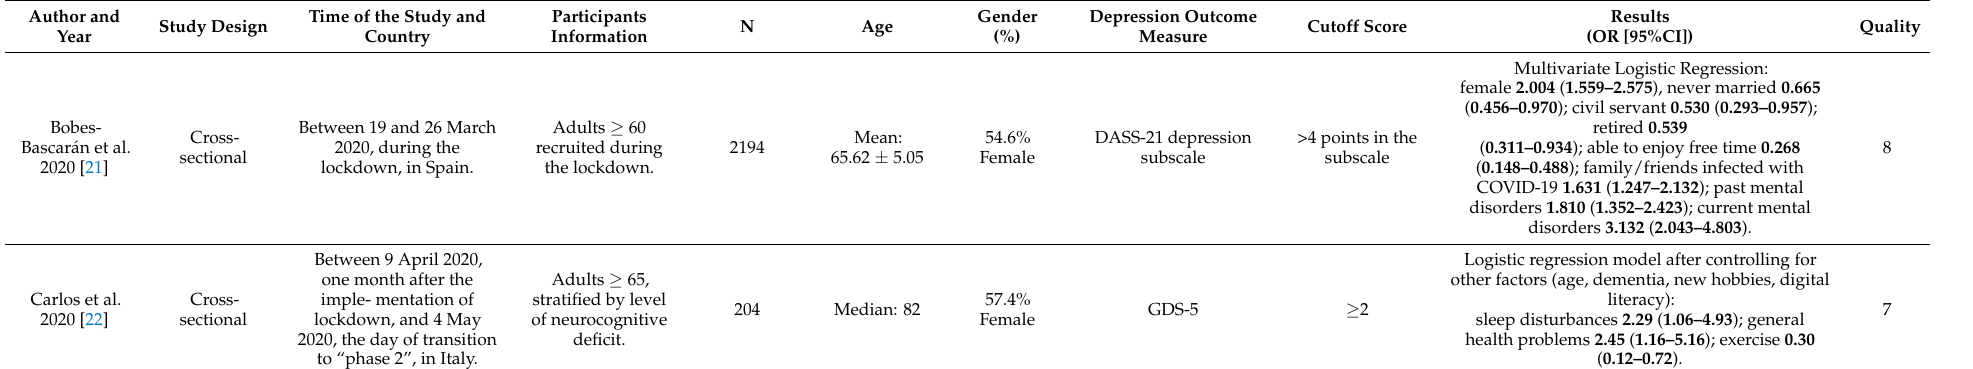
Table 1. Studies included that analyse factors associated with